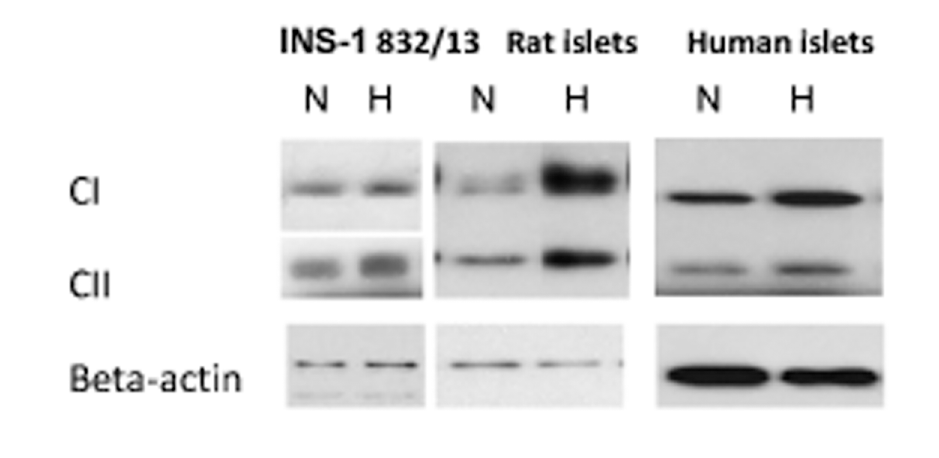
Fig 6. Effects of hypoxia on mitochondrial complexes I and II. Immunoblotting of subunits of the complexes were performed on cells and islets that were harvested after hypoxia followed by re-oxygenation (H) or continuous normoxia (N). Representative Western blots are